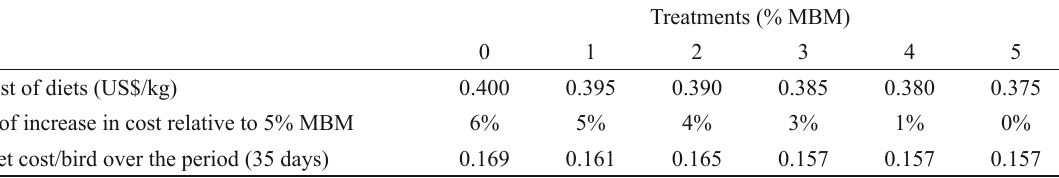
Cost of diets (in US$) with increasing proportions of meat and bone meal (MBM) in replacement of soybean meal fed to Japanese quail aged 1 to 35 days. Individual quail prices were the same for all diets (US$